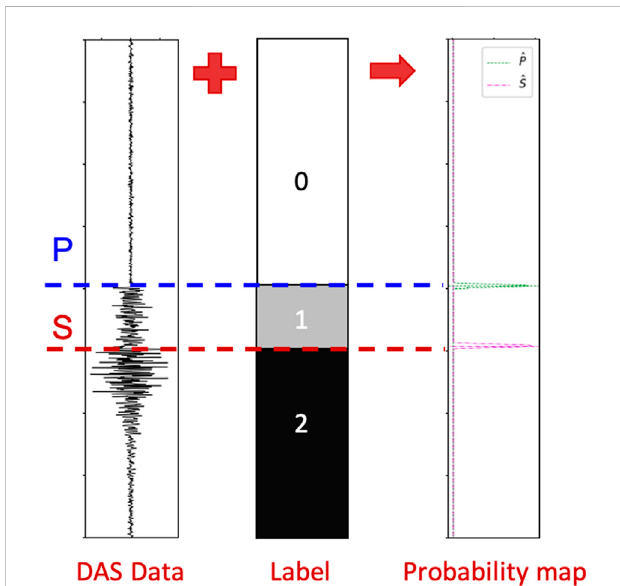
FIGURE 4 Arrival time picking method. The manual picked P- and S-wave times are marked with blue and red dashed lines, respectively. The trainingdatacontainsthelabels(0,1or2).Thetrainednetworkproduces probability densities for P- and S-arrivals.